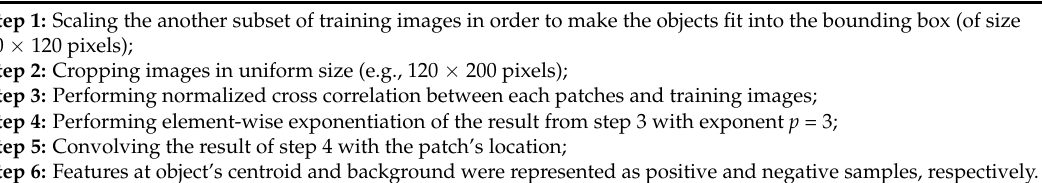
Table 2. The process of collecting training samples.